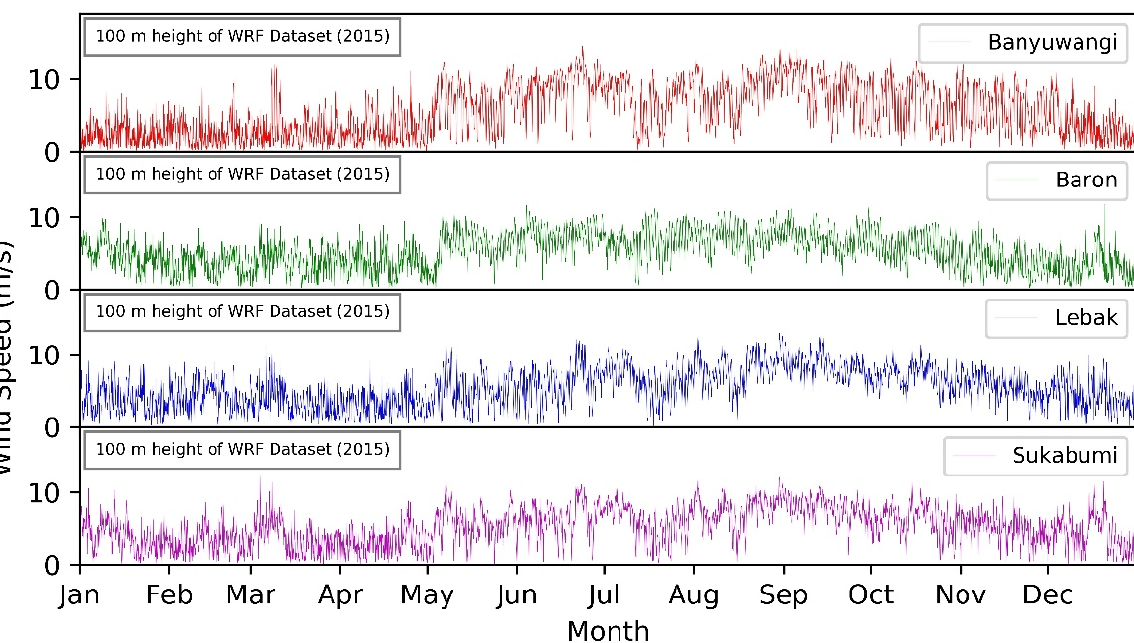
Figure 4. WRF wind speed at 100 m for onshore sites in 2015.